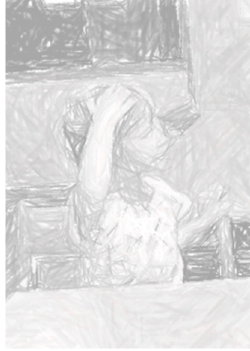
Figure 3. One of the children showing a change of perspective, feeling sorry for the king, holding her head stating that “he was sick, poor king.”